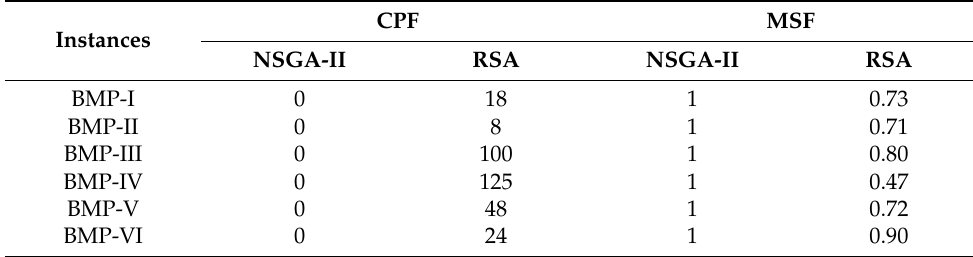
Table 4. Performance comparison of algorithms.